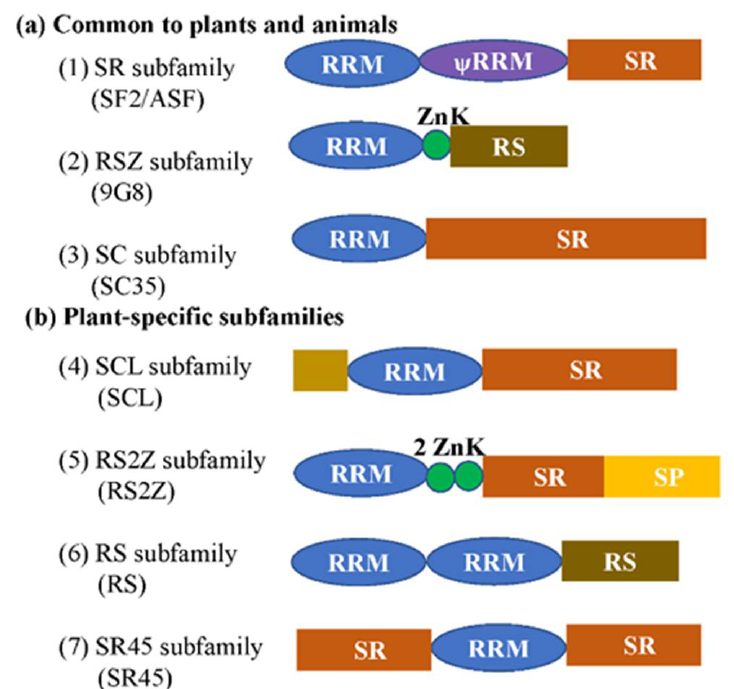
Figure 1. Schematic representation of plant SR proteins. ( a ) Three subfamilies are common to plants and animals. ( b ) Subfamilies that are specific for the plant kingdom. The subfamily names without brackets are from [5], while ones with brackets are from [6]. RRM, RNA recognition motif; ψ RRM, RRM (contains the SWQDLKD motif, which is present in all SF2/ASF homologs); SR, domain rich in serine-arginine dipeptides; RS, domain rich in arginine and serine; ZnK, zinc knuckle of CCHC type; SP, domain rich in serine and proline. The brown rectangle indicates the rare domains which could be diverse.